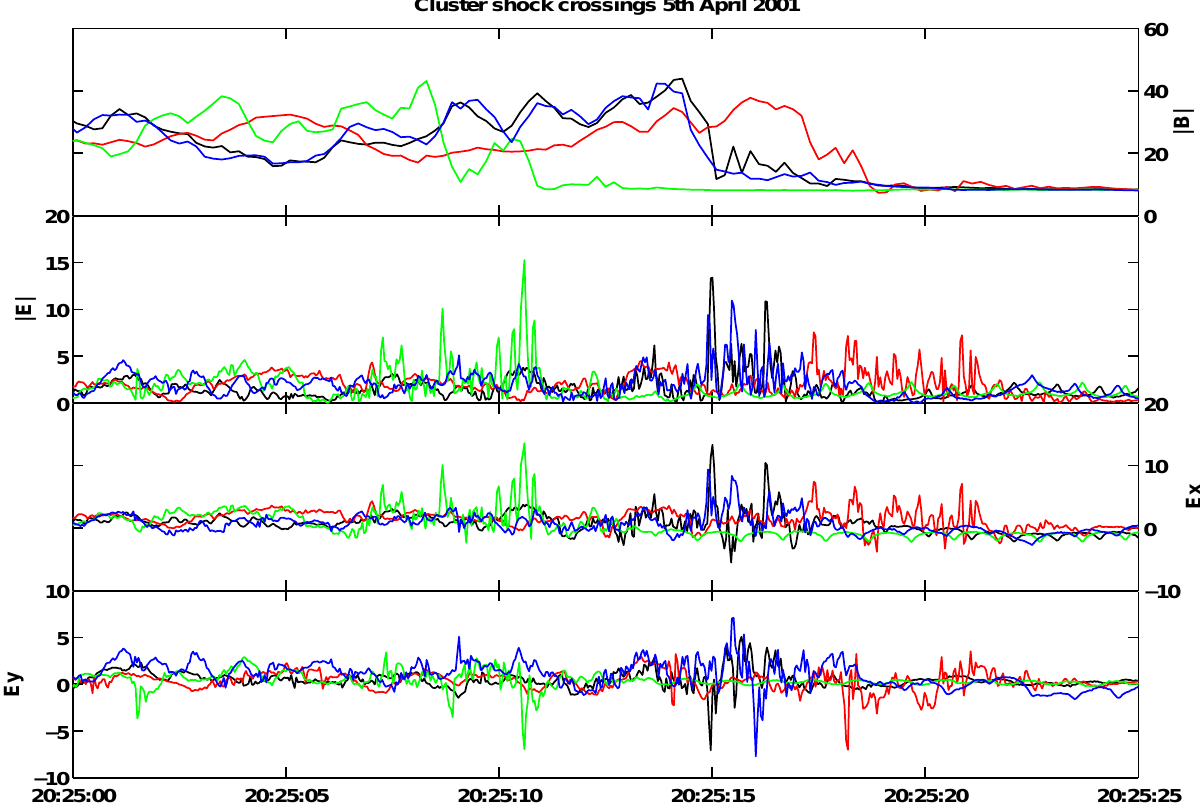
Fig. 6. Overview of the shock crossings on 5 April 2001 at 20:24 UT. The top panel shows the magnitude of the magnetic field as measured by FGM. The lower panels show the electric field magnitude and components measured in the spin plane of the